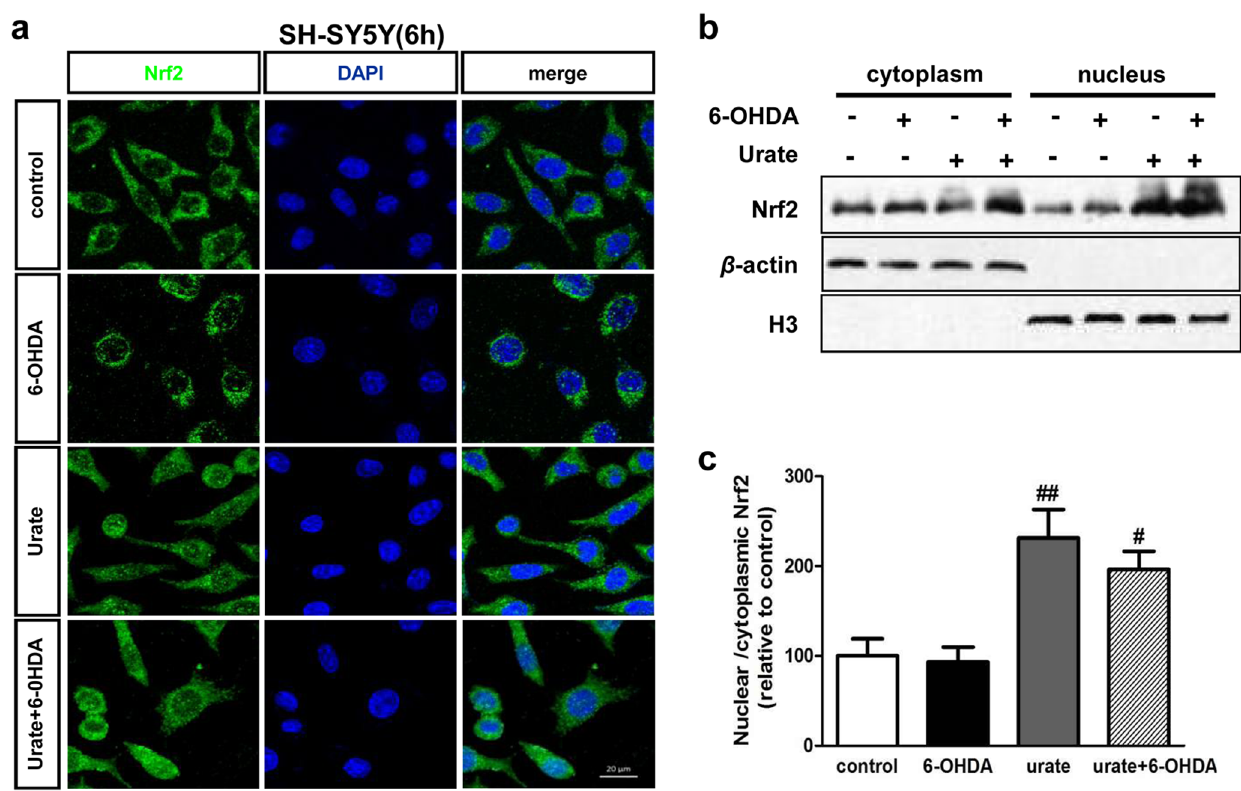
Figure 5. Effect of urate on the subcellular distribution of Nrf2 in SY-SY5Y cells. Cells were pre-incubated with urate for 30 min prior to 6- OHDA treatment for 6 h. ( a ) Representative pictures showing the subcellular distribution of Nrf2 (FITC/green) in SH-SY5Y cells. Nuclei were stained with DAPI (blue). Scale bar=20 m m. ( b, c ) Cytoplasmic and nuclear fractions were prepared and subjected to immunoblotting analysis. H3 and b - actin were used for nuclear and cytoplasmic protein markers, respectively. Mean 6 SEM, n=4. # P , 0.05 versus 6-OHDA group; ## P , 0.01 versus control.